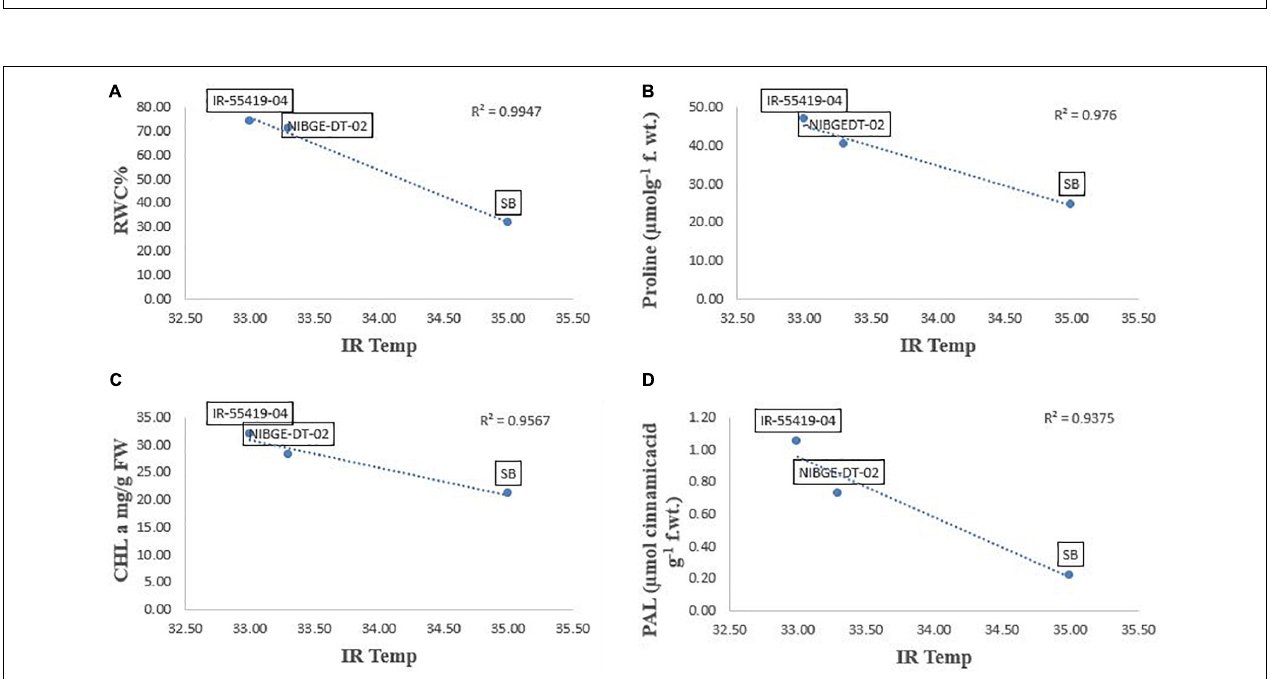
FIGURE 9 | Correlation analysis of Infrared (IR) temperature with different traits for three tested genotypes under later-stage stress conditions. (A) Relationship between IR-temperature and RWC%. (B) Relationship between IR-temperature and proline content. (C) Relationship between IR-temperature and chlorophyll a (CHL a). (D) Relationship between IR-temperature and PAL enzymes. Relationships were studied by correlation analysis using SPSS software. Means are an average of four biological replicates at p = 0.05 according to the LSD.